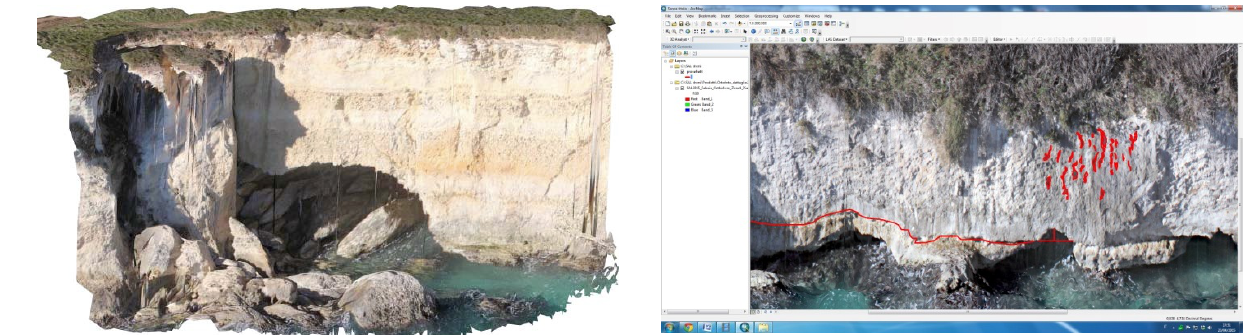
Figure 5: Orthophoto with an arched cavity